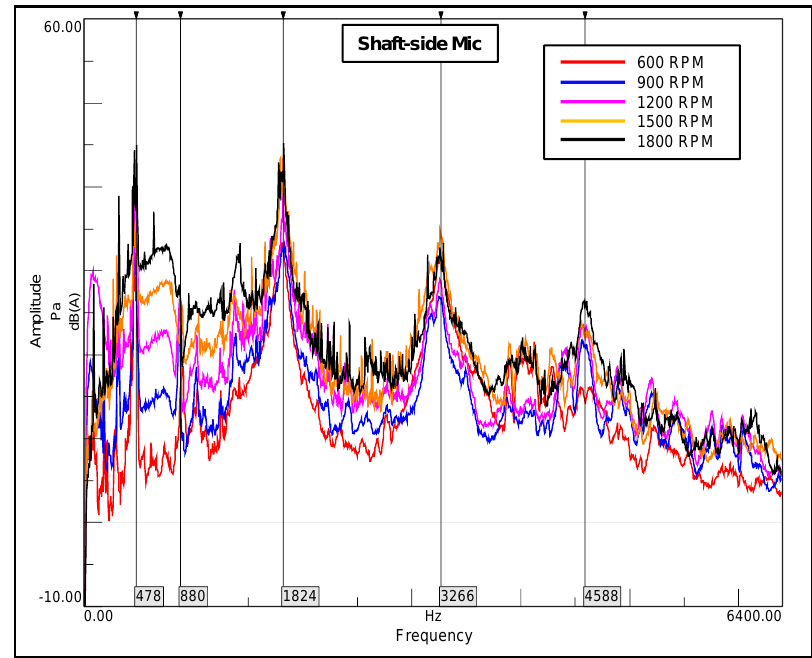
Figure 8. Acoustic auto-power spectrum from the shaft side microphone with RMS dB(A) values at synchronous speeds of 600, 900, 1200, 1500, and 1800 RPM.